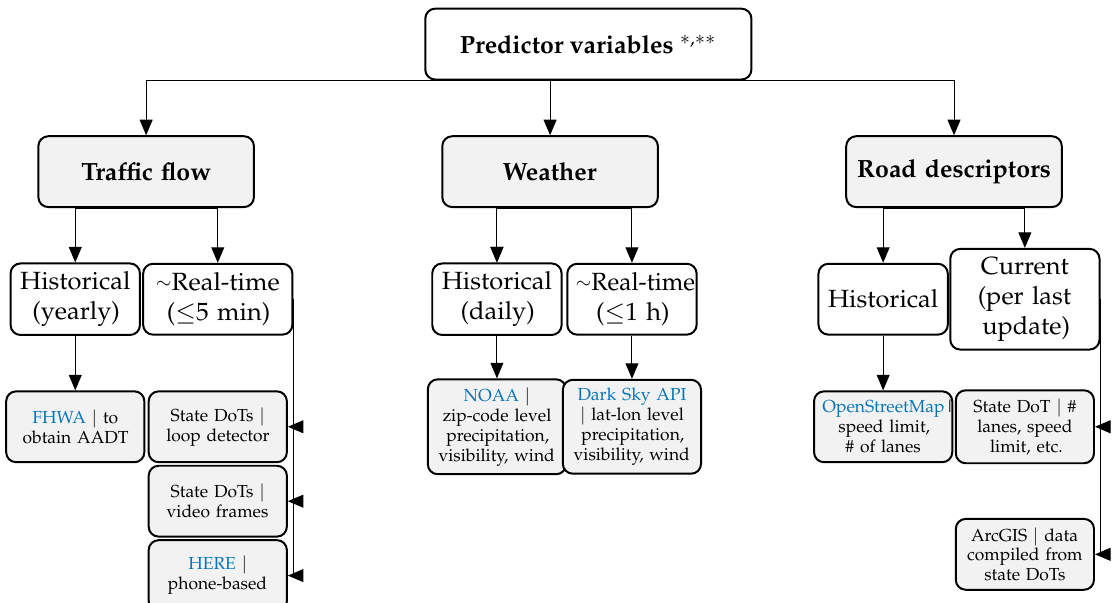
Figure 3. A hierarchy of predictor variables used in modeling crash risk. The first level captures the data type, the second level shows the frequency, and the third level highlights examples